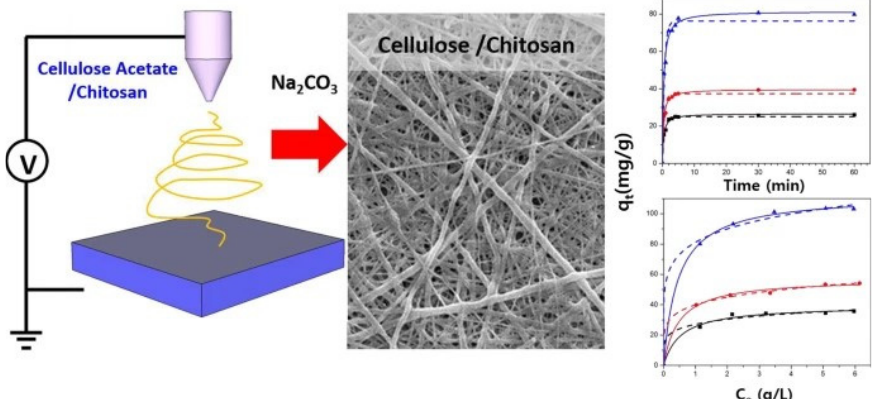
Figure 14. Cellulose chitosan composite nanofibres made via electrospinning from a trifluoroacetic and acetic acid co-solvent system and treated further with Na 2 CO 3 . Reprinted with permission from: Springer Nature, CELLULOSE [156] (Fabrication of electrospun chitosan/cellulose nanofibers having adsorption property with enhanced mechanical property, Phan, Duy-Nam, Lee, Hoik, Huang, Bijun, Mukai, Yasuhito, Kim, Ick-Soo) Copyright (2018).